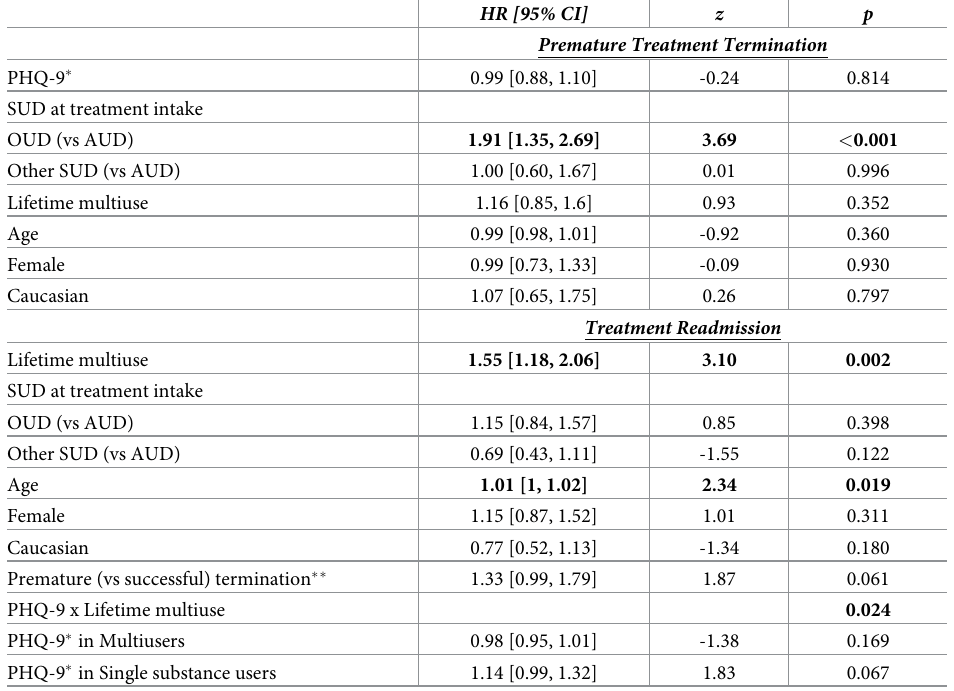
Table 2. Analysis for the premature treatment termination and treatment readmission